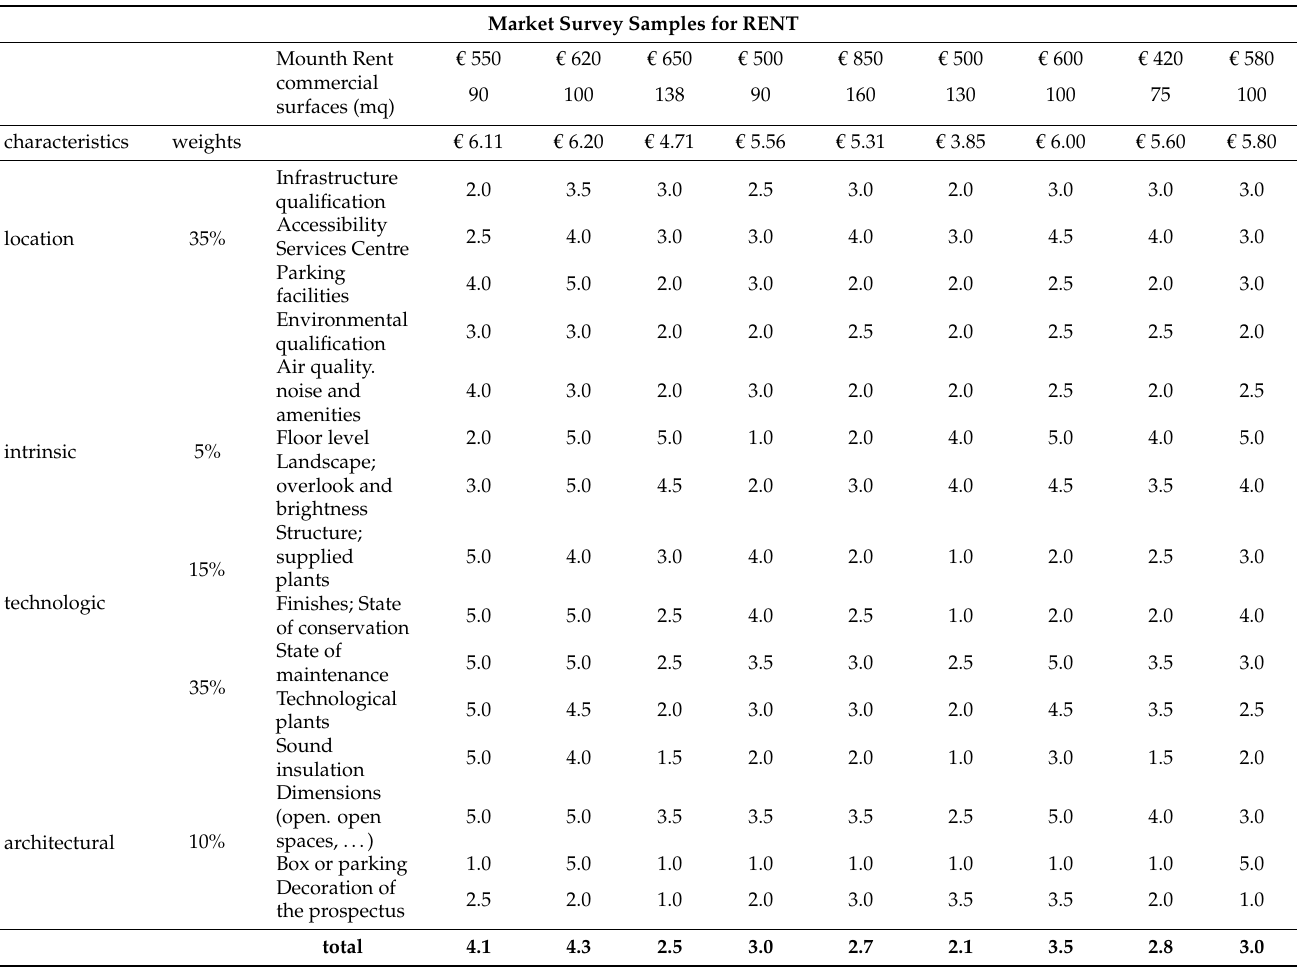
Table 2. Excerpt of the real estate market value